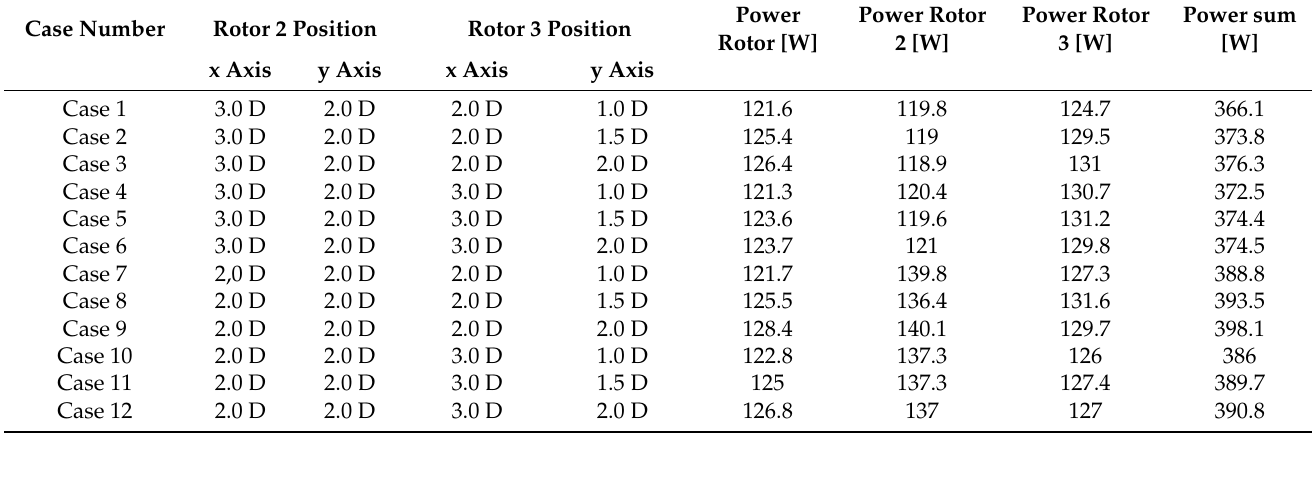
Table 6. Arrangement cases for three rotors and power of each rotor.